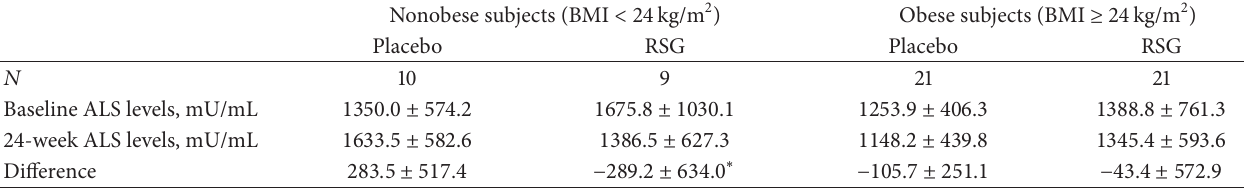
Table 3: Changes of serum ALS levels by treatment in subjects categorized as nonobese (BMI < 24 kg/m 2 ) or obese (BMI ≥ 24 kg/m 2